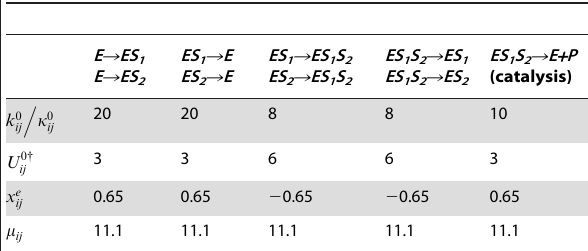
Table 2. Model parameters for transitions between different enzyme states for the reaction scheme in Fig.